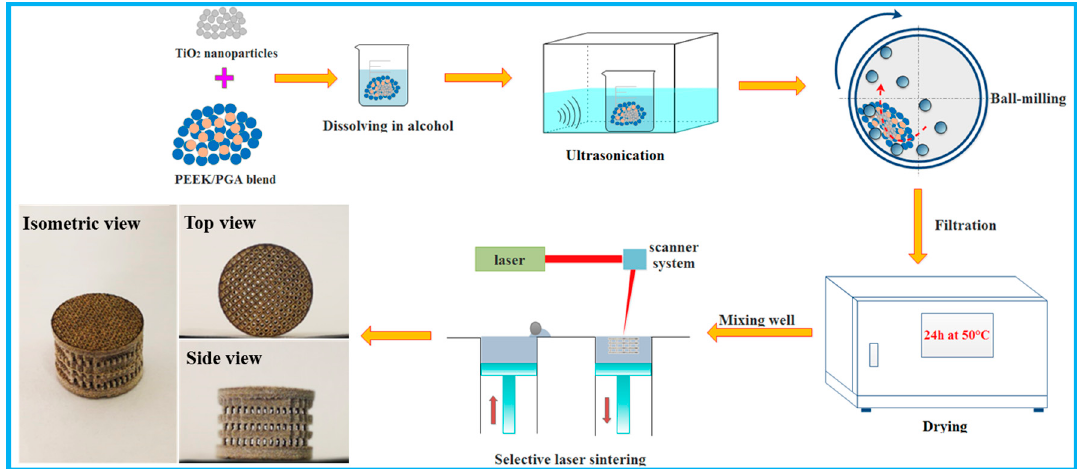
Figure 1. Schematic of the scaffold preparation process.